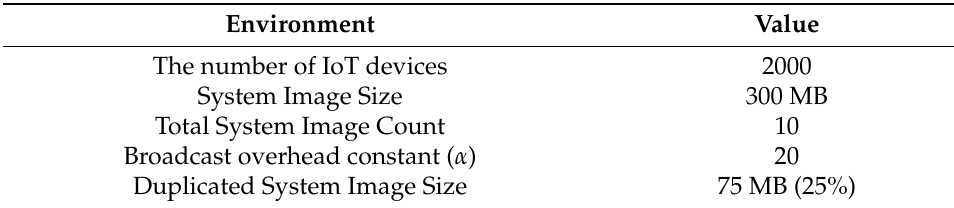
Table 1. Adaptive transfer experimental environment.